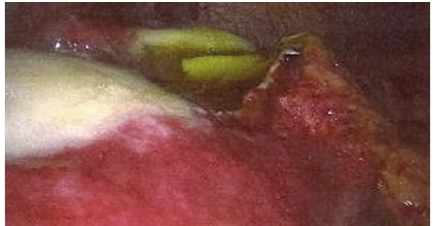
Figure 2: Intra-operative laparoscopy image demonstrating the ruptured cyst and folded hyaline membrane within. Hydatid fluid is leaking from the ruptured